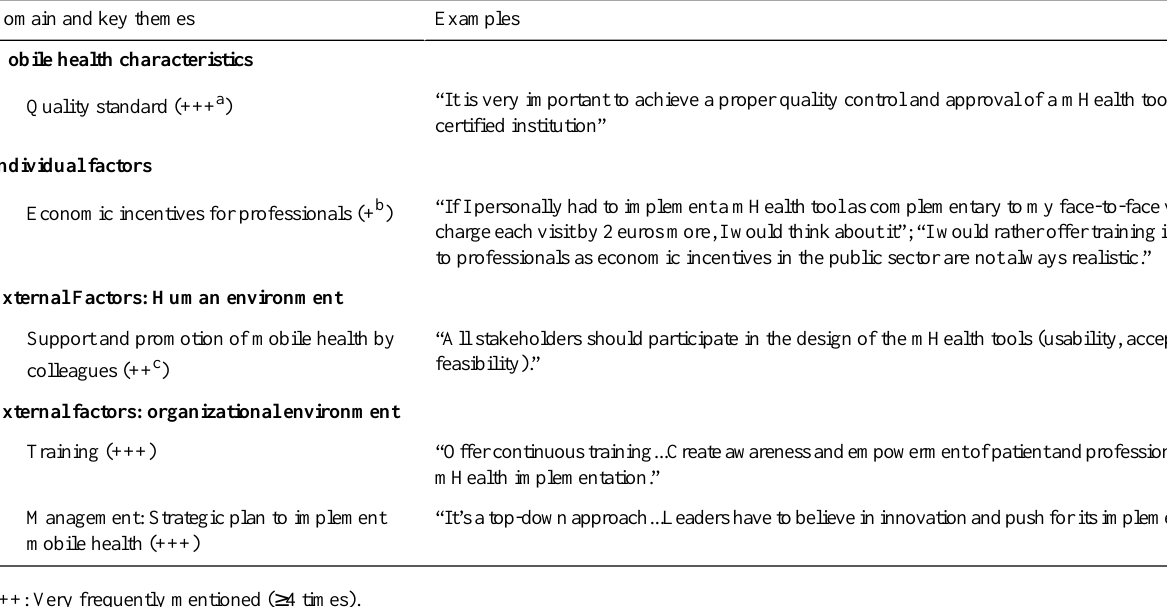
Table 4. Drivers relating to mobile health adoption by health care providers and mobile health